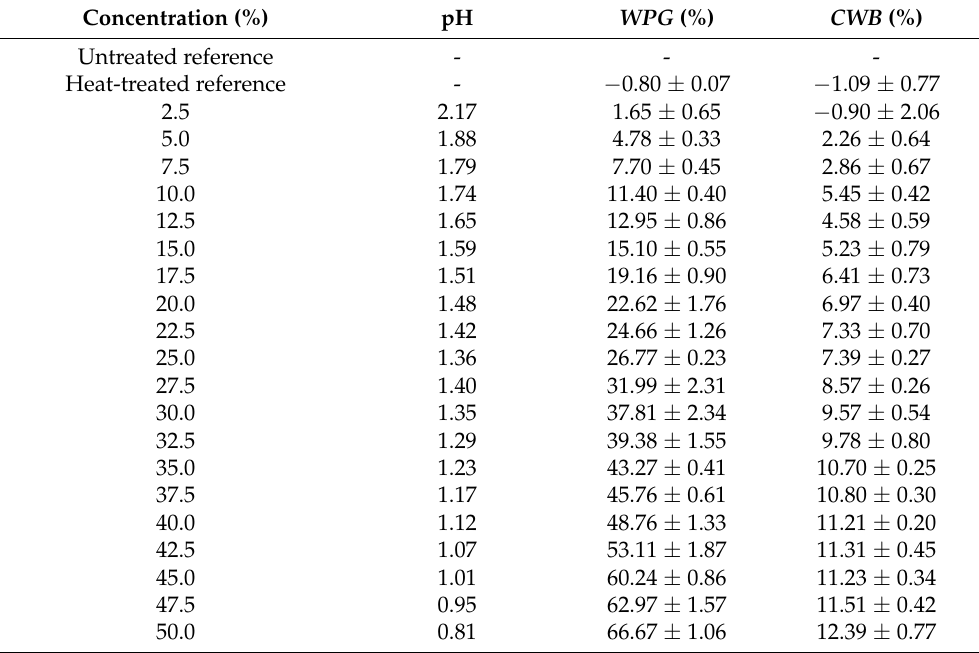
Table 1. Concentration (in %) and pH of the impregnation solutions measured at ca. 20 ◦ C, together with the weight percent gain ( WPG , in %) and cell wall bulking ( CWB , in %) of the specimens modified with respective solutions and subsequently